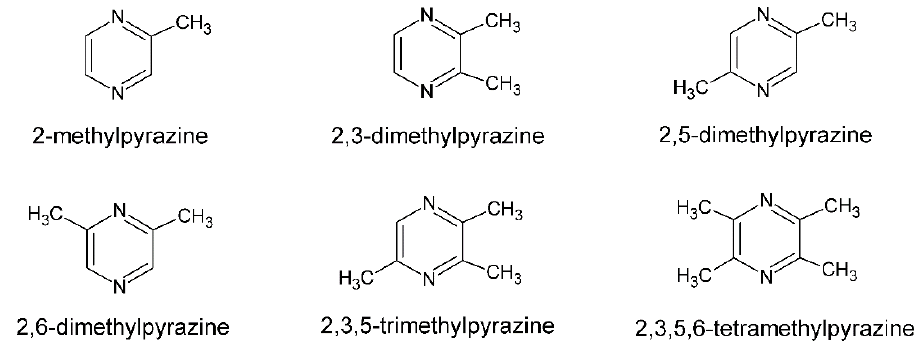
Figure 1. Structural formulae of alkylpyrazines [10].